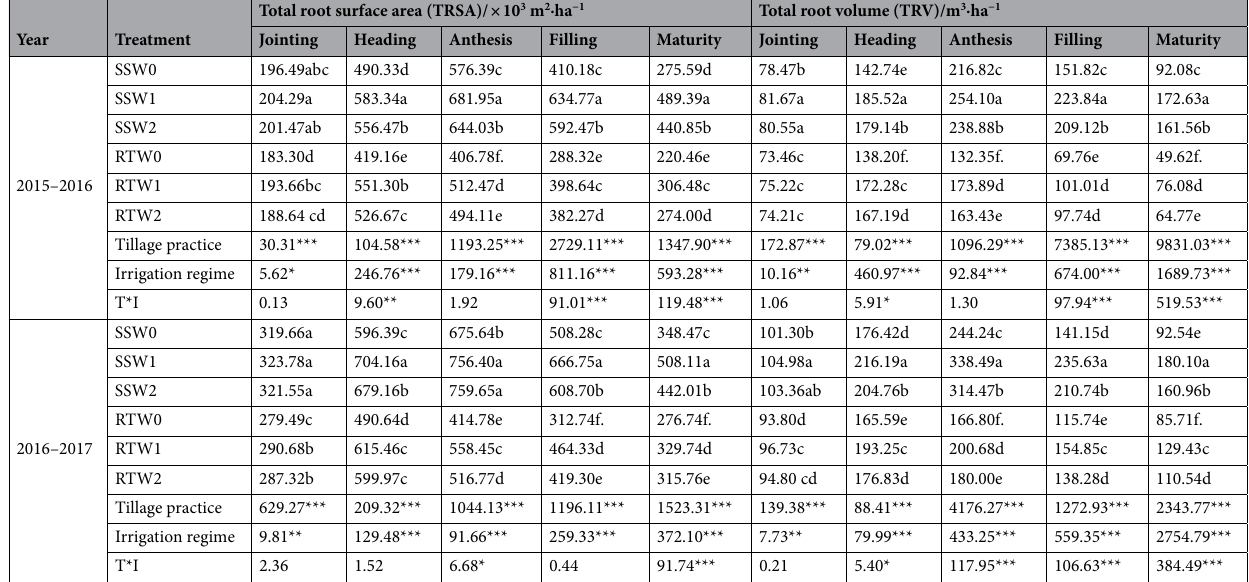
Table 3. Effects of tillage practice and irrigation regime on the total root surface area and total root volume of winter